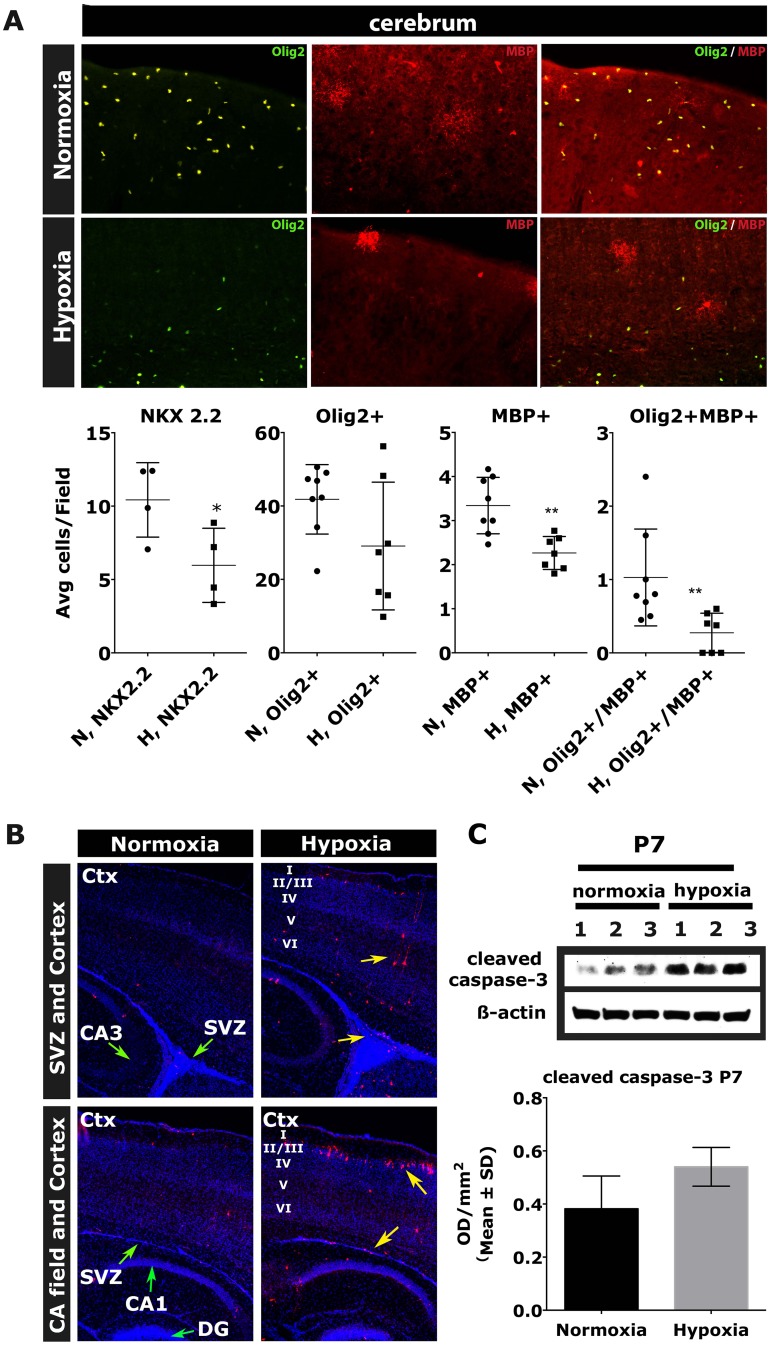
Abbreviated hypoxia (P3 → P7) does not increase levels of OPCs but causes substantial apoptosis throughout cortical layers, hippocampus and SVZ.A: Immunohistochemistry and stereologic analysis of mouse cerebra at P13 using OL markers Olig-2 (OPCs, immature OLs, mature OLs), MBP (mature OLs) and NKX2.2 (OPCs). B: Immunohistochemical staining of level matched hypoxic and control cerebra at P7 showing anti-CC3 (red) and nuclear marker DAPI (green arrows indicate specific regions SVZ, DG and CA1/3 field; yellow arrows mark levels of high apoptotic intensity in hypoxic mice). C: Representative Western blots using total brain homogenates from hypoxic and control CD1 mice at P7 using apoptosis marker CC3 and β-actin as a loading control. Densitometric analysis of Western blots from 3 independent experiments showing brain levels of CC3 at P7 in hypoxic and control mice with *** equals p < 0.001; ** equals p < 0.01; * equals p < 0.05.. SVZ, subventricular zone; DG, dentate gyrus; CA1-3, hippocampal CA fields; Ctx, cortex, I-VI = cortical layers 1–6. (n = 6 hypoxic + 6 normoxic animals for immunohistochemistry and Western blotting (each)).